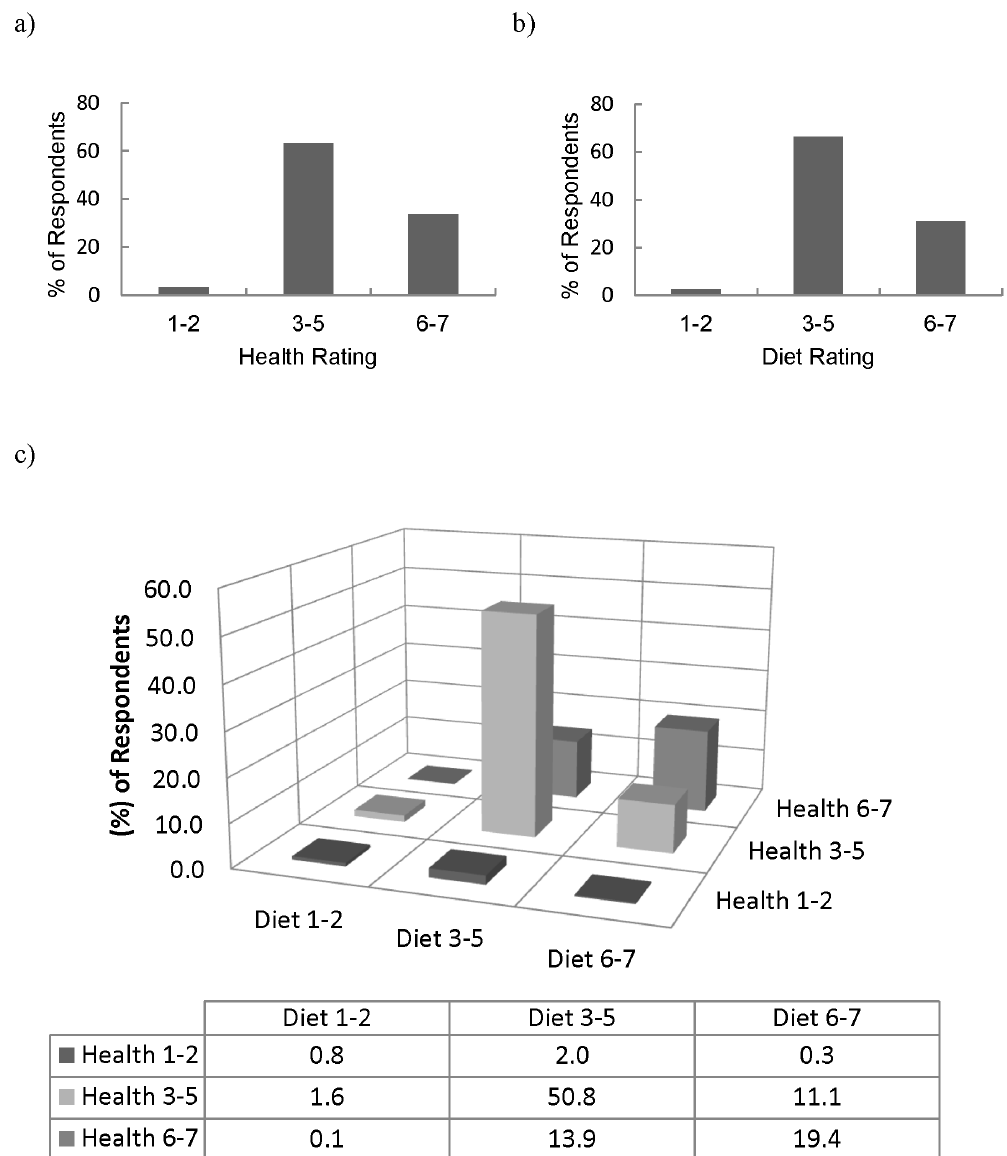
Figure 1. Self-reported ratings of overall diet and health status by CCM respondents* (N=6,665). (a) Rating of overall health status { ; (b) Rating of overall diet status ` ; (c) Concordance of self-reported overall health status with diet status by respondent. *Respondents were weighted to be representative of the Canadian population by age, sex, and province according to the 2006 census data. { 1=very unhealthy; and 7=very healthy; ` 1=poor; and 7=excellent; CCM: Canadian Consumer Monitor.